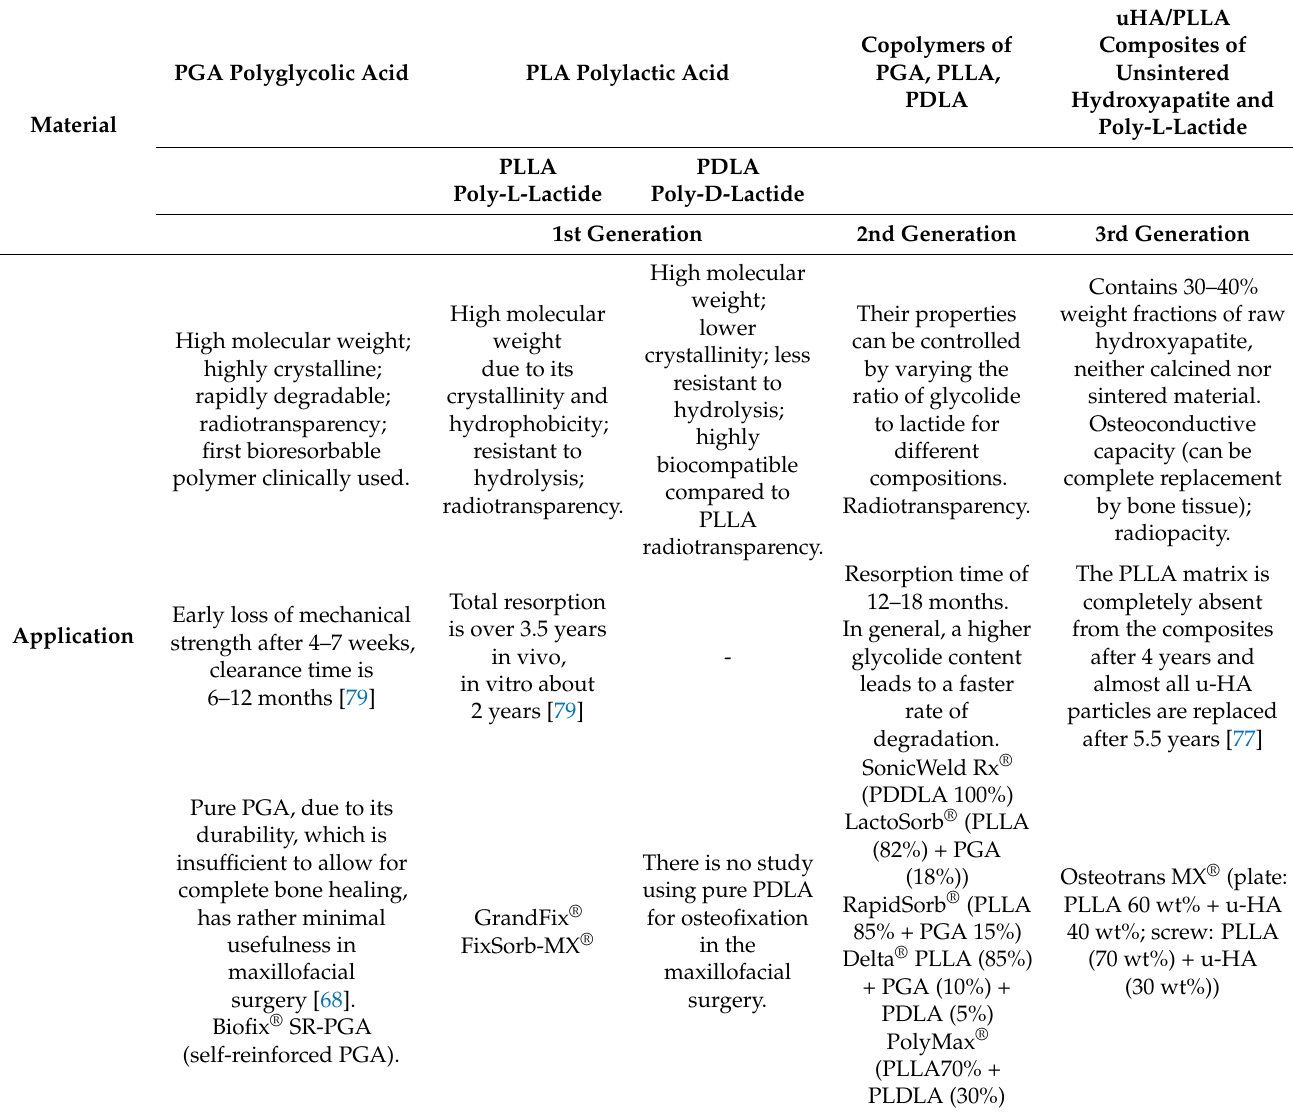
Table 1. Characteristics of bioresorbable materials and commercially available systems for maxillofa- cial